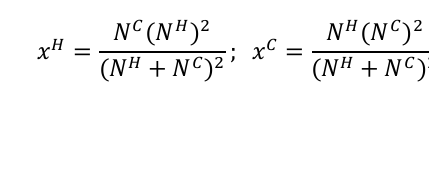
Fig. 4. Situation where Fig. 5. Situation